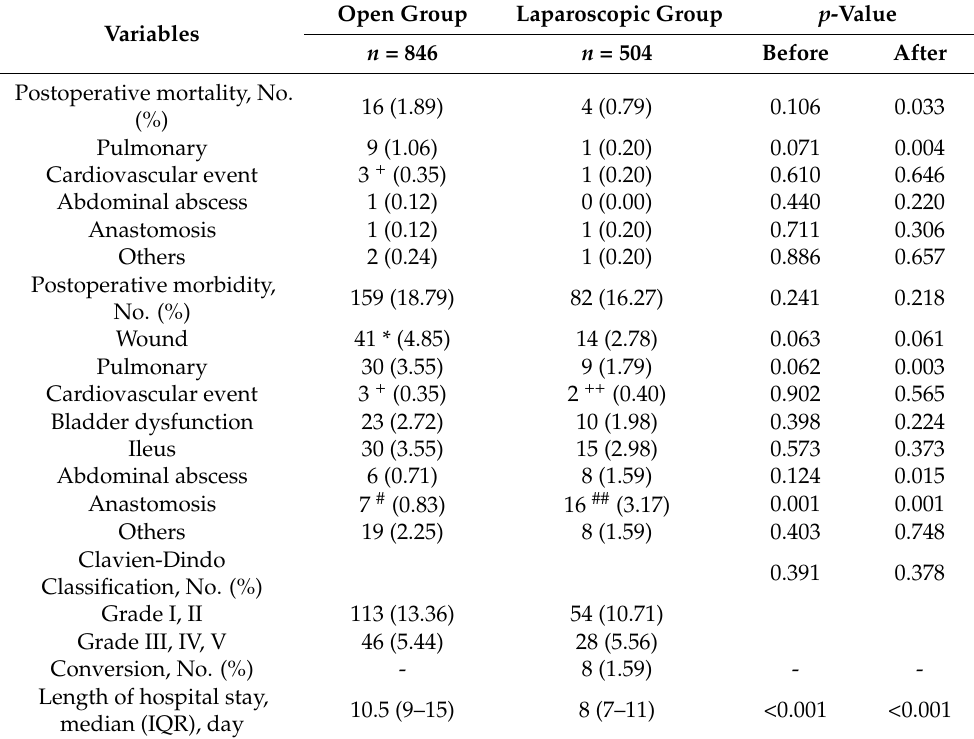
Table 2. Postoperative outcomes of patients treated with open surgery vs. laparoscopy before and after propensity score